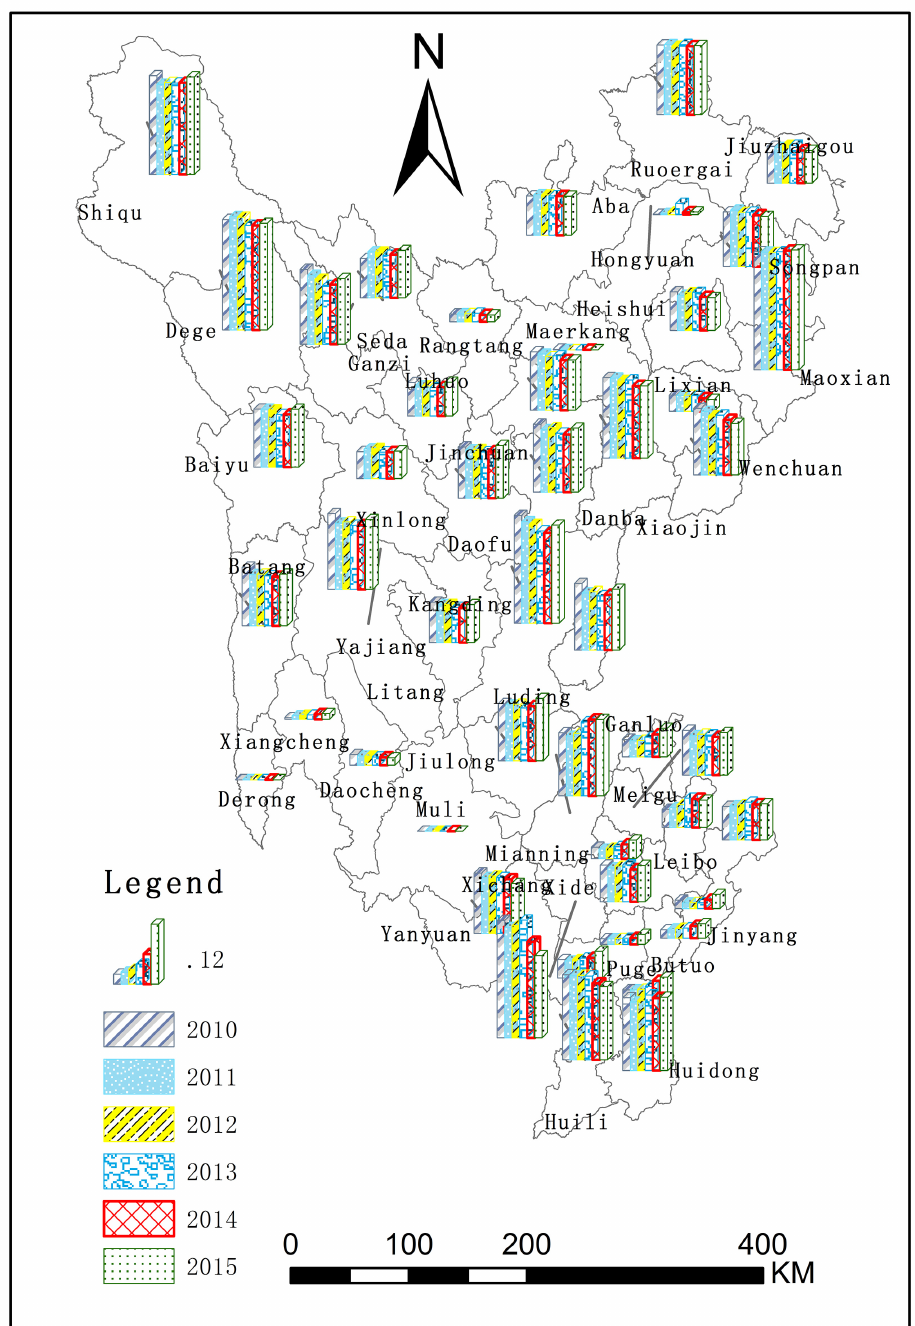
Figure 7. Human capital